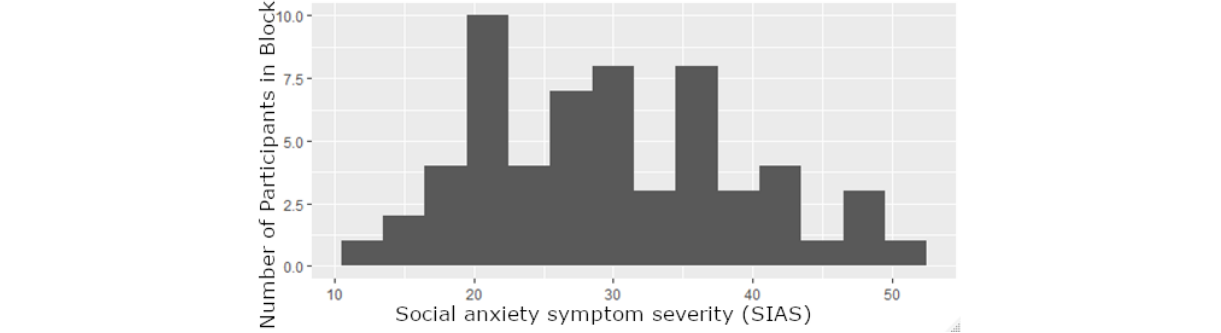
Figure 1. Social anxiety symptom severity based on the social interaction anxiety scale.